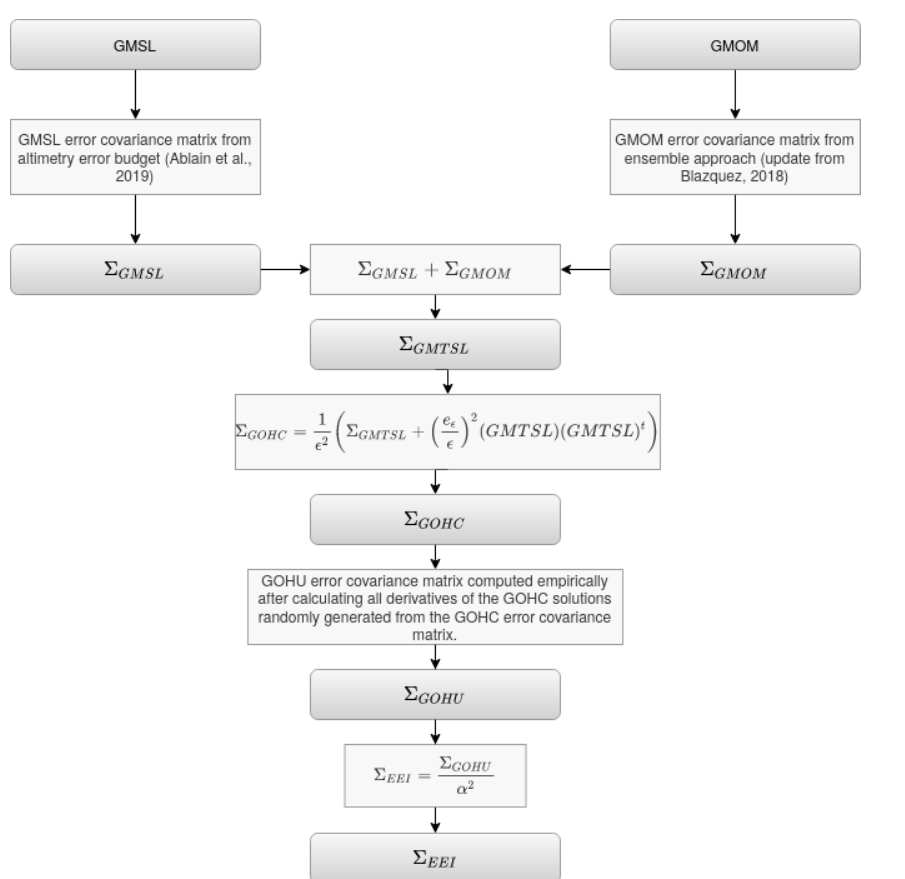
Figure 2. Propagation of errors from the global mean sea level (GMSL) change and global mean ocean mass (GMOM) change time series until the global ocean heat content (GOHC) change and Earth energy imbalance (EEI) time